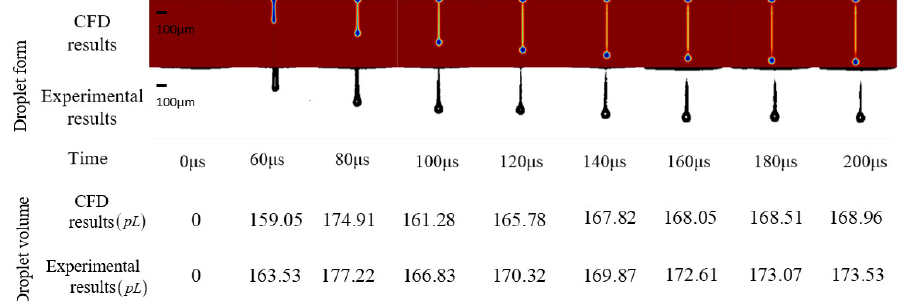
Figure 13. Comparison of xanthan gum solution CFD result and experimental result at the condition of the modified driving waveform.